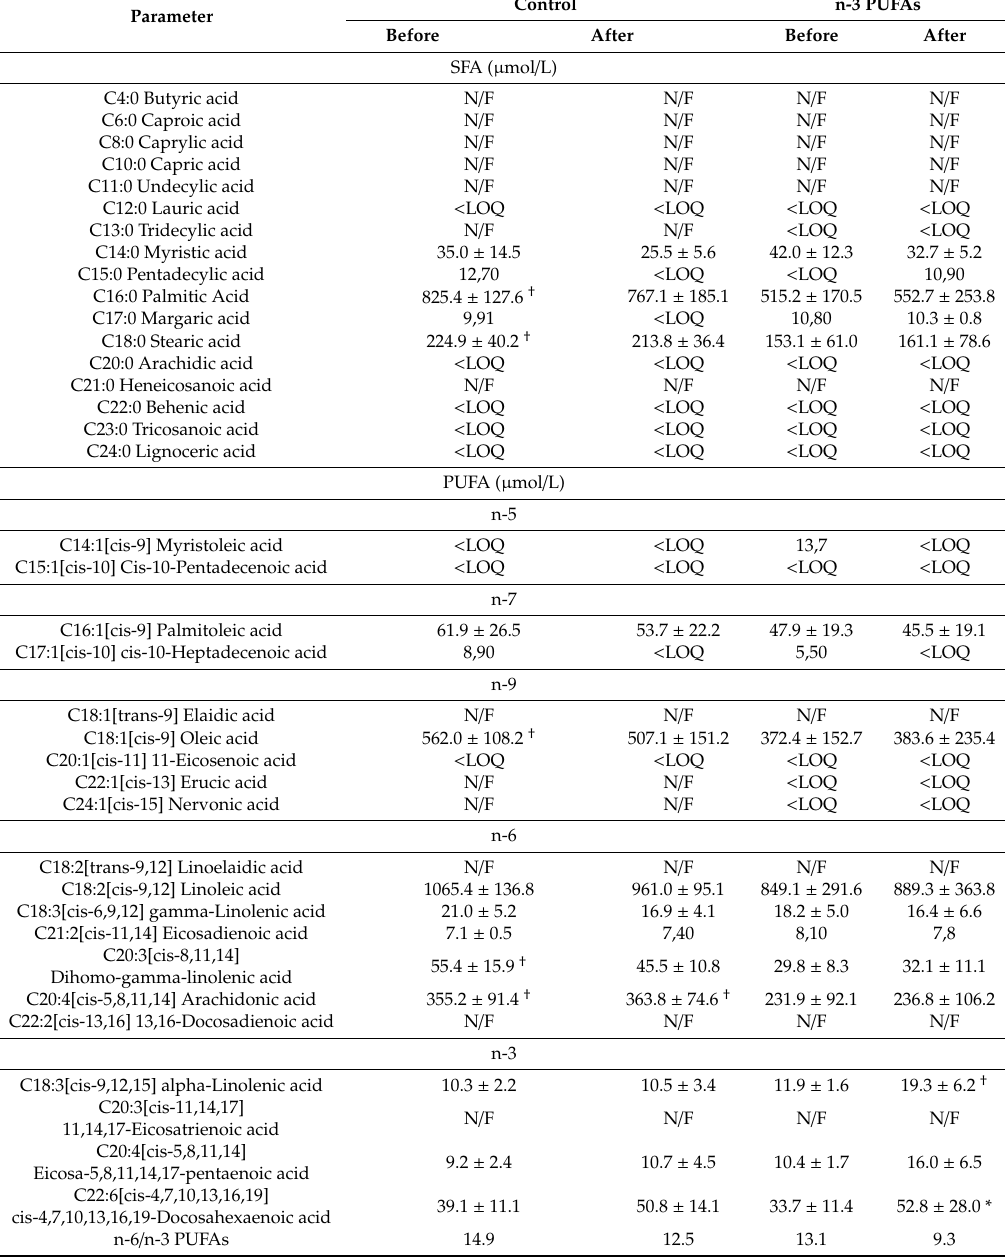
Table 5. The e ff ect of regular (Control group) and n-3 PUFAs enriched hen eggs (n-3 PUFAs group) consumption on serum fatty acids